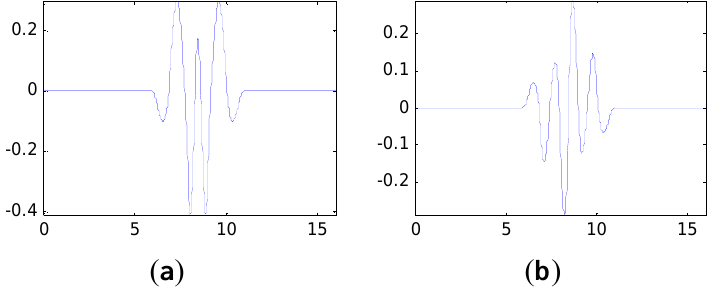
Figure 11. The multiwavelet condition 1. ( a )